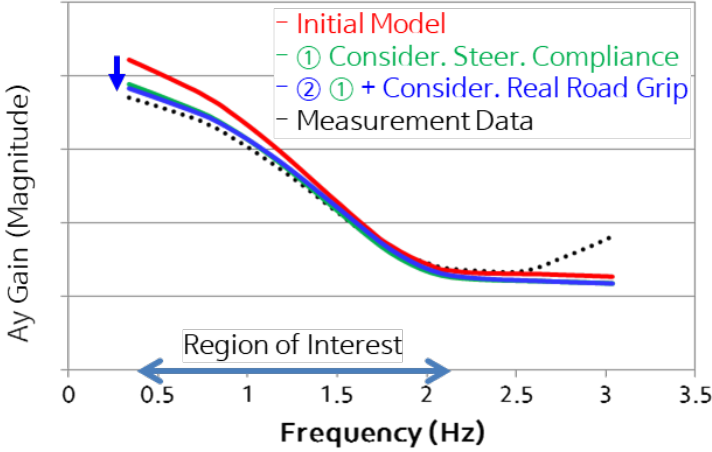
Figure 8. Estimation results of the toe compliance characteristics.